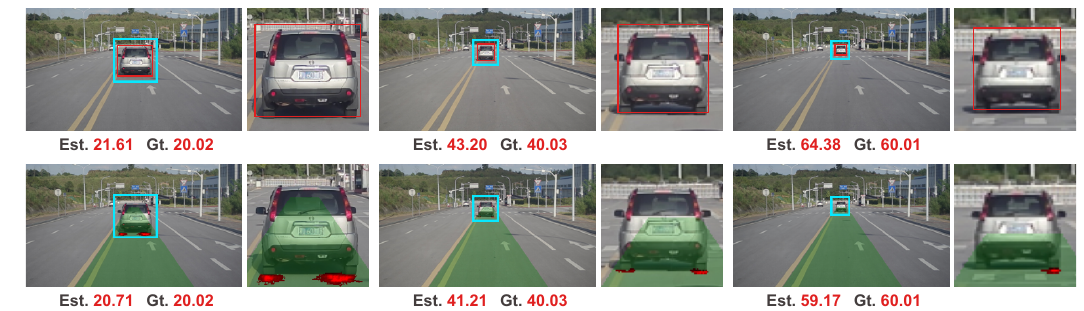
Figure 12. Samples of results in our collected sequence. The results of the Inverse Perspective Mapping (IPM)-based method are shown in the top row. The results of our method are shown in the bottom row.